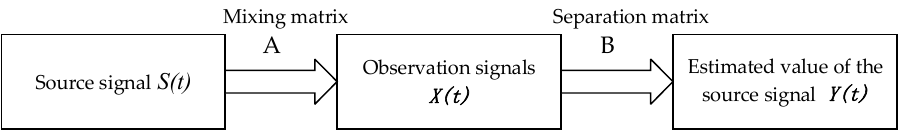
Figure 1. Instantaneous linear blind source separation (BSS) system model.